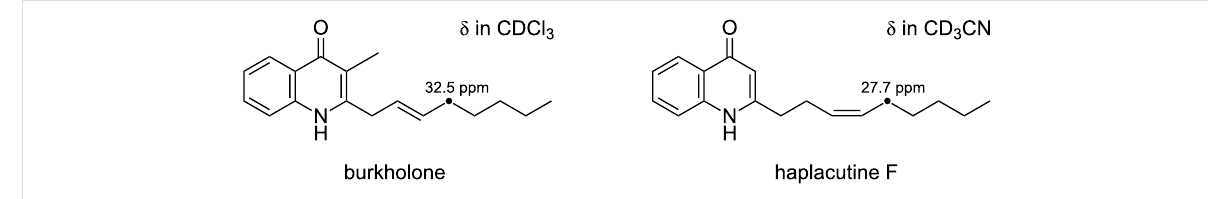
Figure 3: Referential 13 C chemical shifts of an allylic carbon in burkholone [14] and haplacutine F [15].